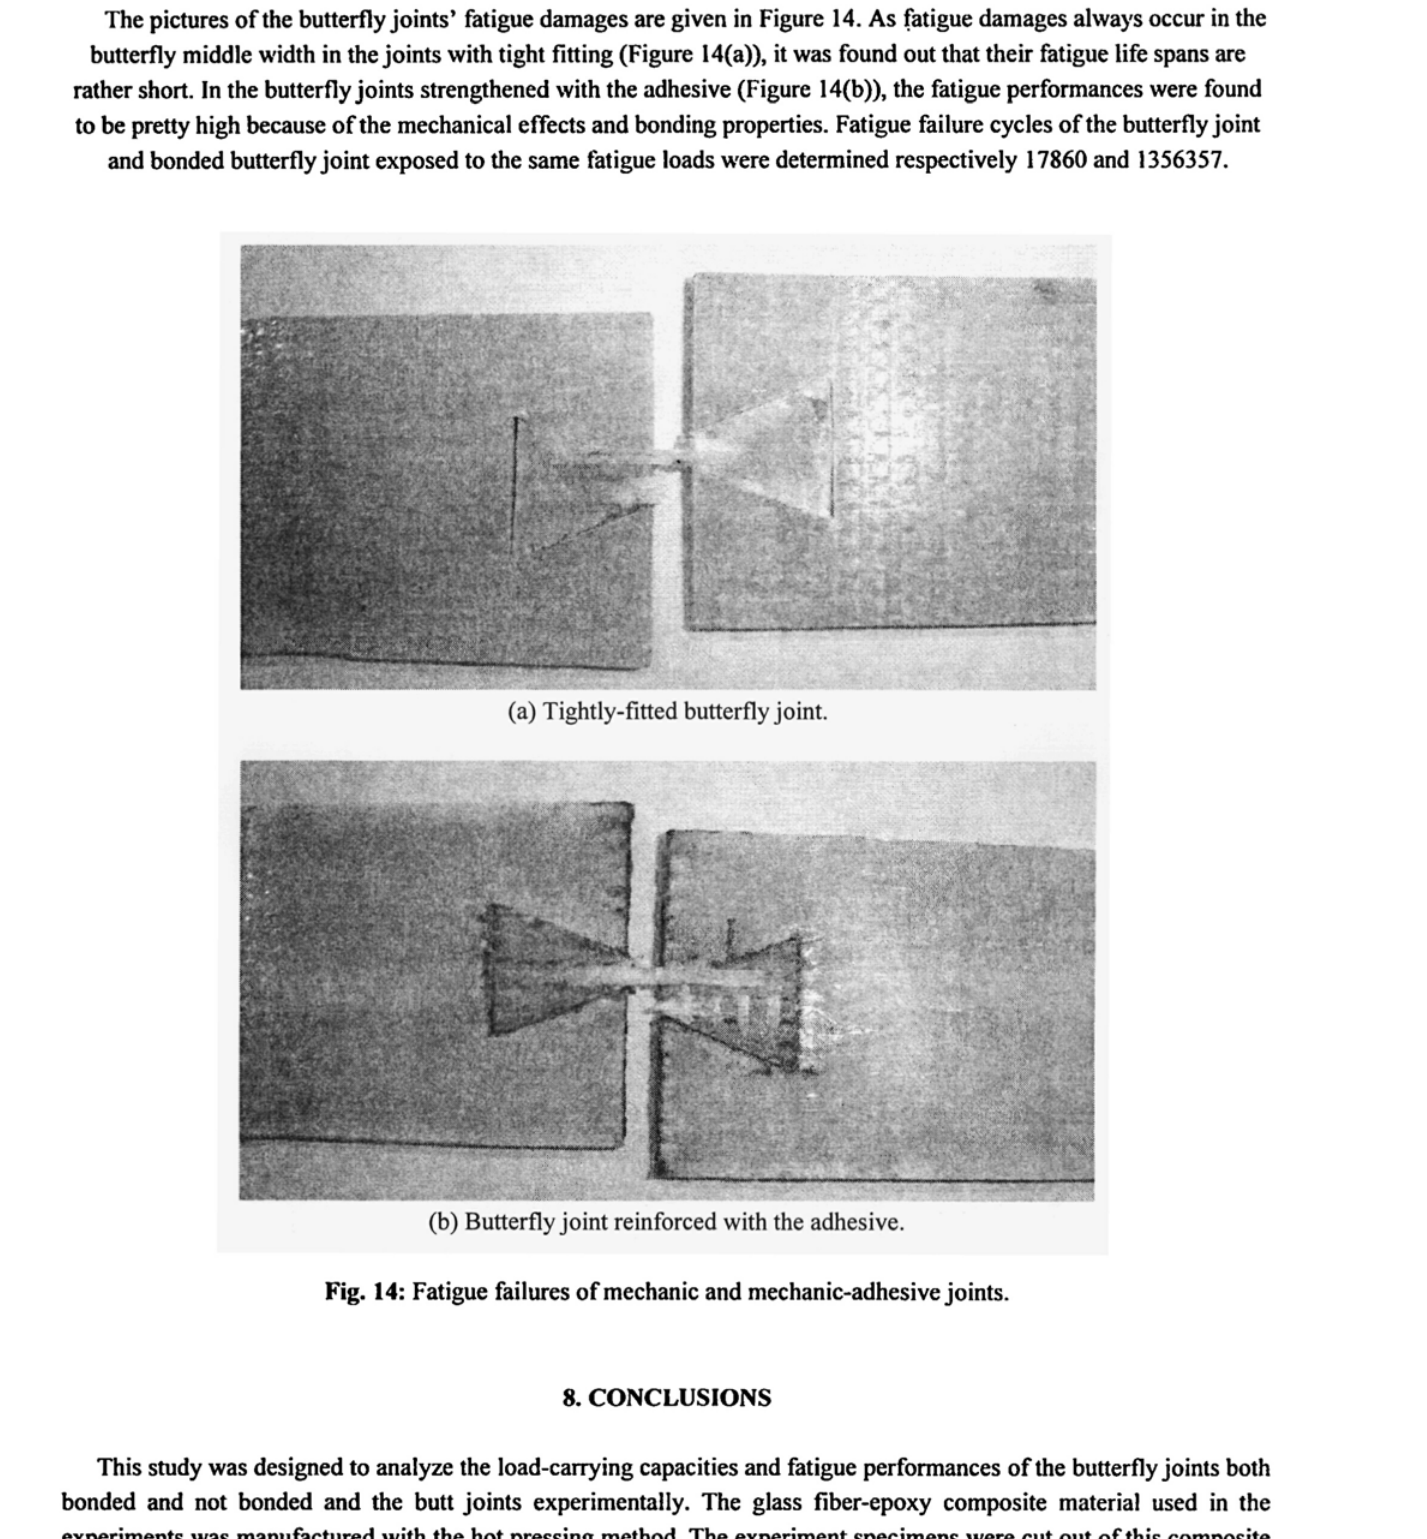
Fig. 14: Fatigue failures of mechanic and mechanic-adhesive